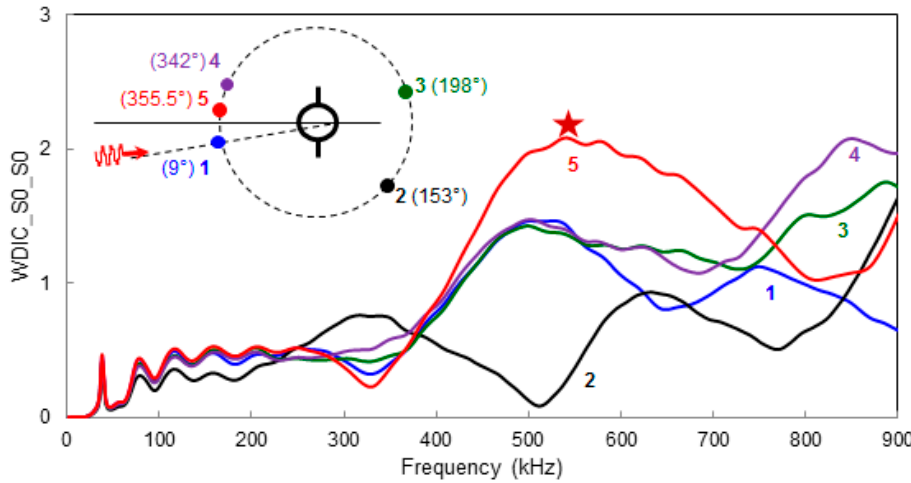
Figure 7. Frequency domain variation of WDIC S0_S0 at different azimuthal positions ( θ “ 9 ˝ ).